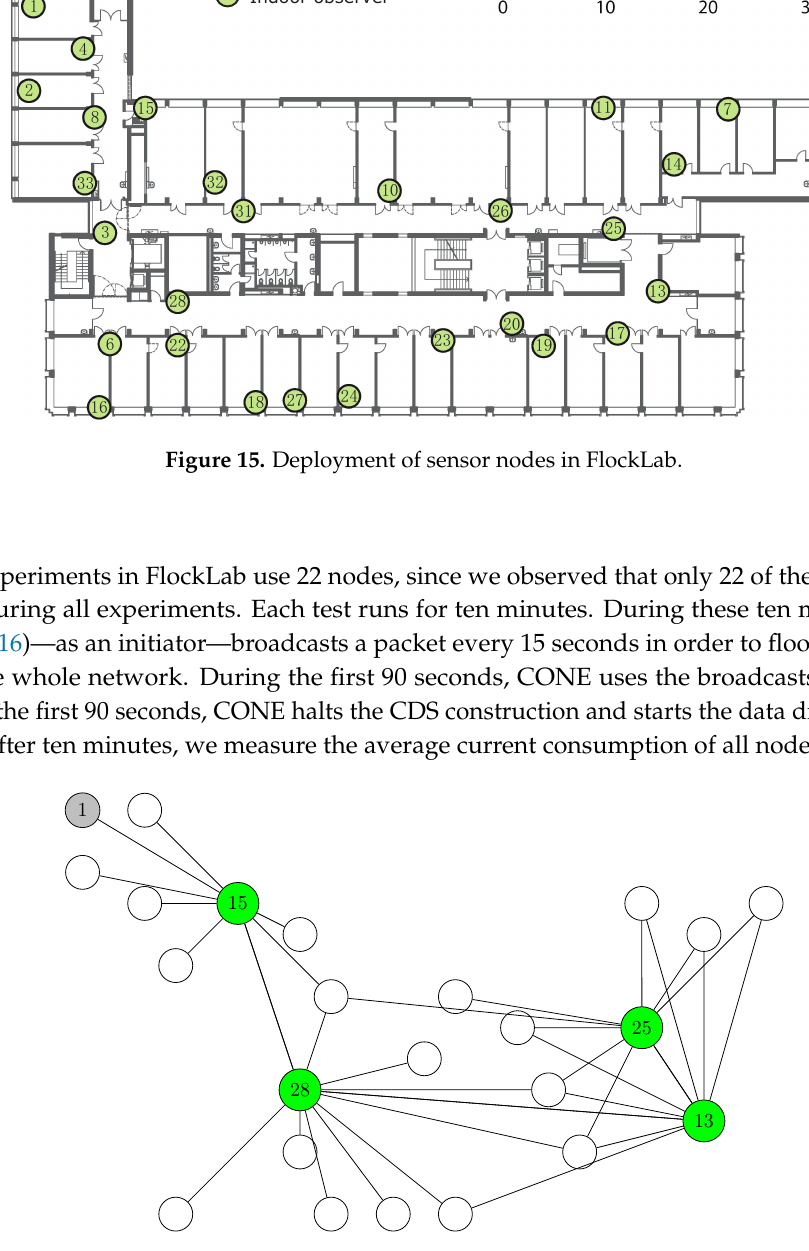
Figure 16. Constructed CDSs in the FlockLab experiments. The dominators are colored in green. The initiator is colored in grey. The edges indicate the active links between nodes. We only show active links between dominators and their neighboring nodes due to the large number of active